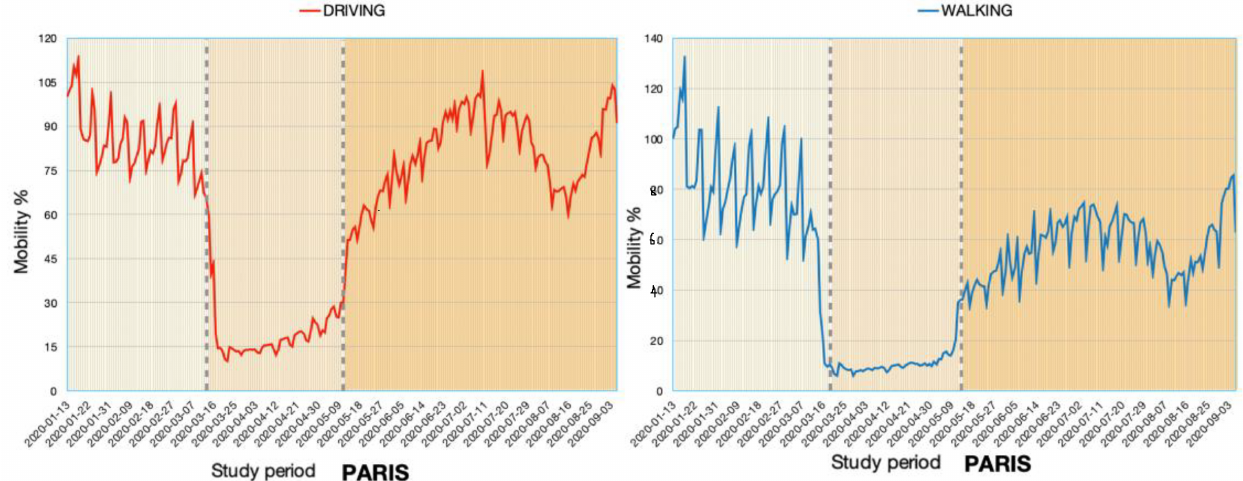
Figure 11. Mobility evolution in Paris from January until September 2020. Source: Own elaboration with data collected from Apple’s mobility trend [22].